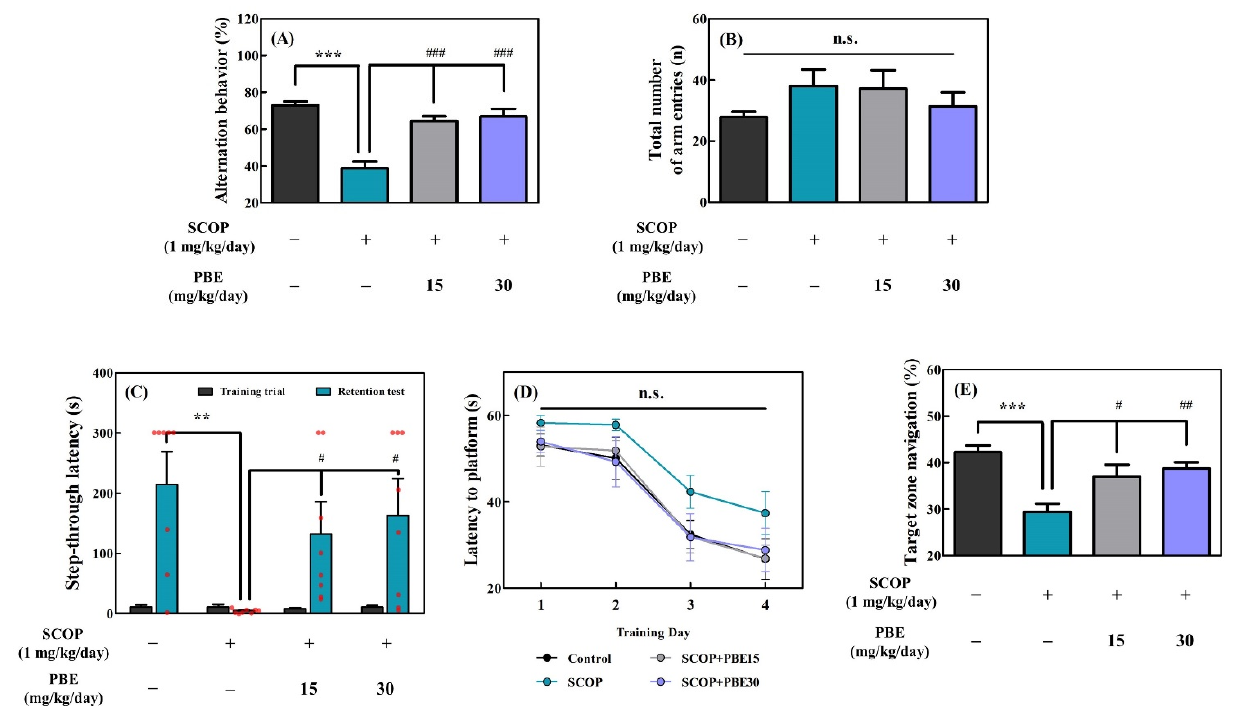
Figure 2. Effects of PBE on the animal behavior tests. SCOP (1 mg/kg/day body weight (BW); i.p. ) was administered to SD rats 30 min before the tests (n = 8). PBE (15 and 30 mg/kg BW/day; p.o. ) was administered to the PBE groups 60 min before the tests. ( A ) Alternation behavior and ( B ) total number of arm entries using the Y-maze test, ( C ) step-through latency time of acquisition trial and retention test in the passive avoidance test, and ( D ) latency time to platform in training days and ( E ) target zone navigation of acquisition trial using the Morris water maze test. Tukey’s honestly significant difference test: ** p < 0.01, *** p < 0.001 vs. control and # p < 0.05, ## p < 0.01, ### p < 0.001 vs.